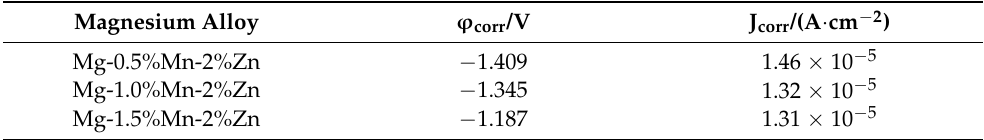
Table 4. Parameters of the Tafel polarization curve of Mg-Mn-Zn alloy .